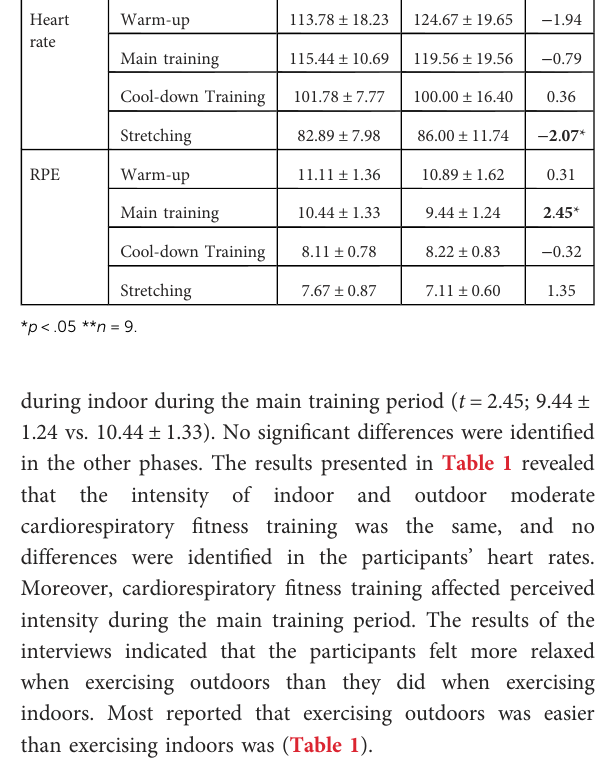
TABLE 1 Participants ’ heart rate and RPE paired sample t -test. Training